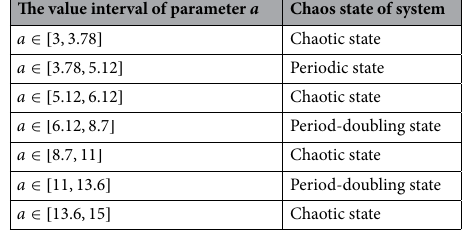
Table 3. The range of parameter a and the corresponding chaotic